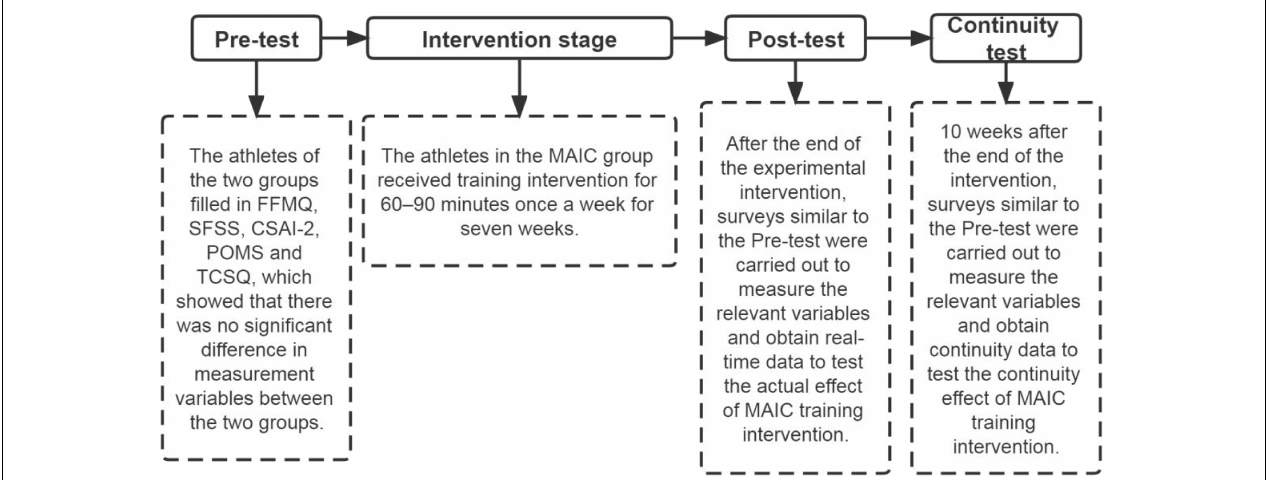
FIGURE 1 | Experimental steps.